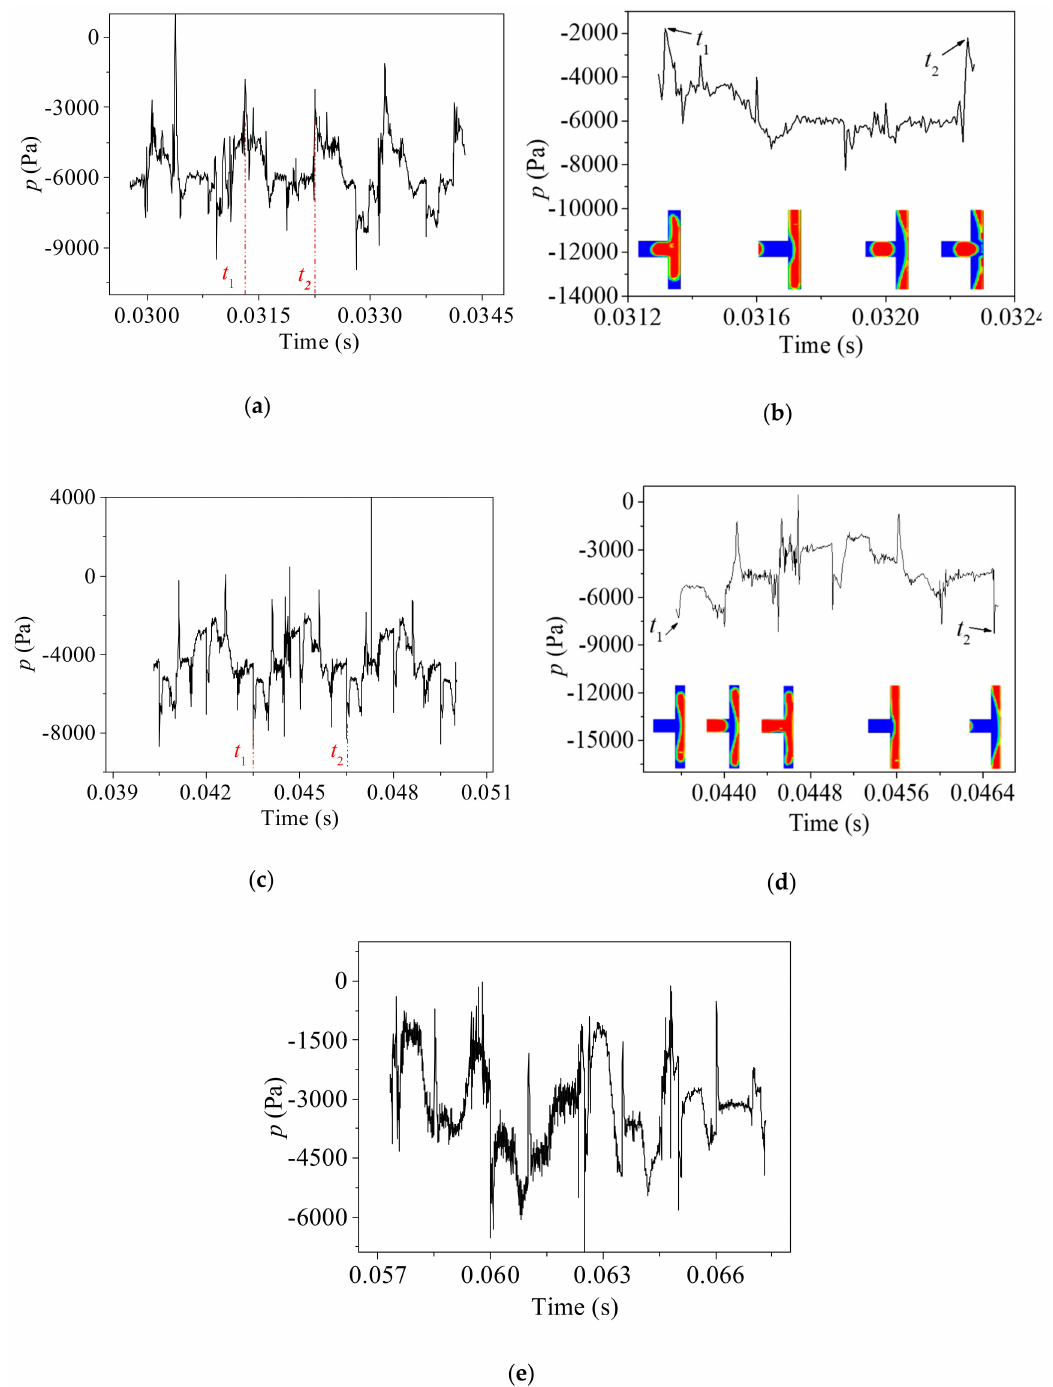
Figure 7. Pressure variation at the center of the third bifurcation. ( a , b ): Ca 0 = 0.0111; ( c , d ): Ca 0 = 0.00694; ( e ): Ca 0 =